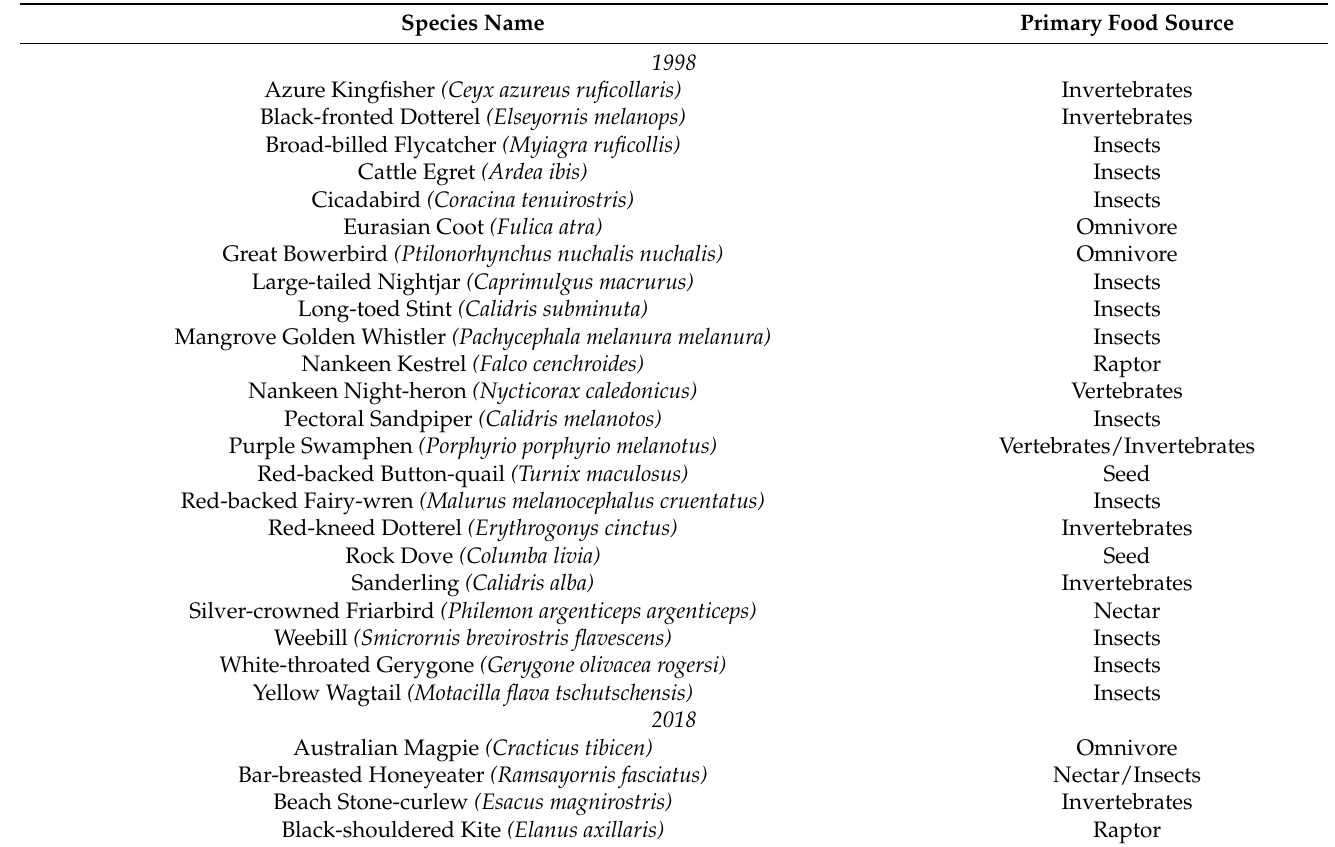
Table A4. Bird species recorded in 1998 only or 2018